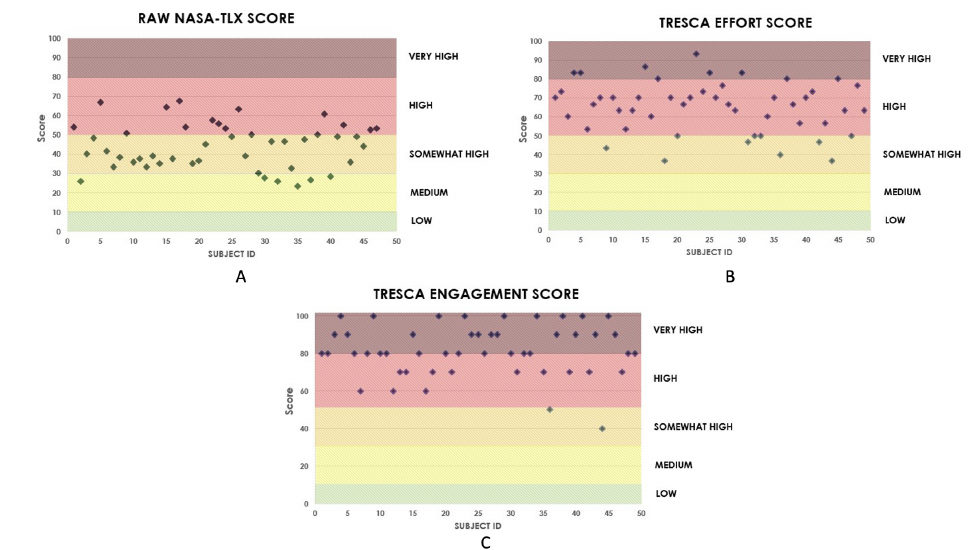
Figure 6. Exergame validation through administered questionnaries. ( A ) NASA-TLX raw score per each subject; ( B ) TRESCA Effort score per each subject; ( C ) TRESCA Engagement score per each